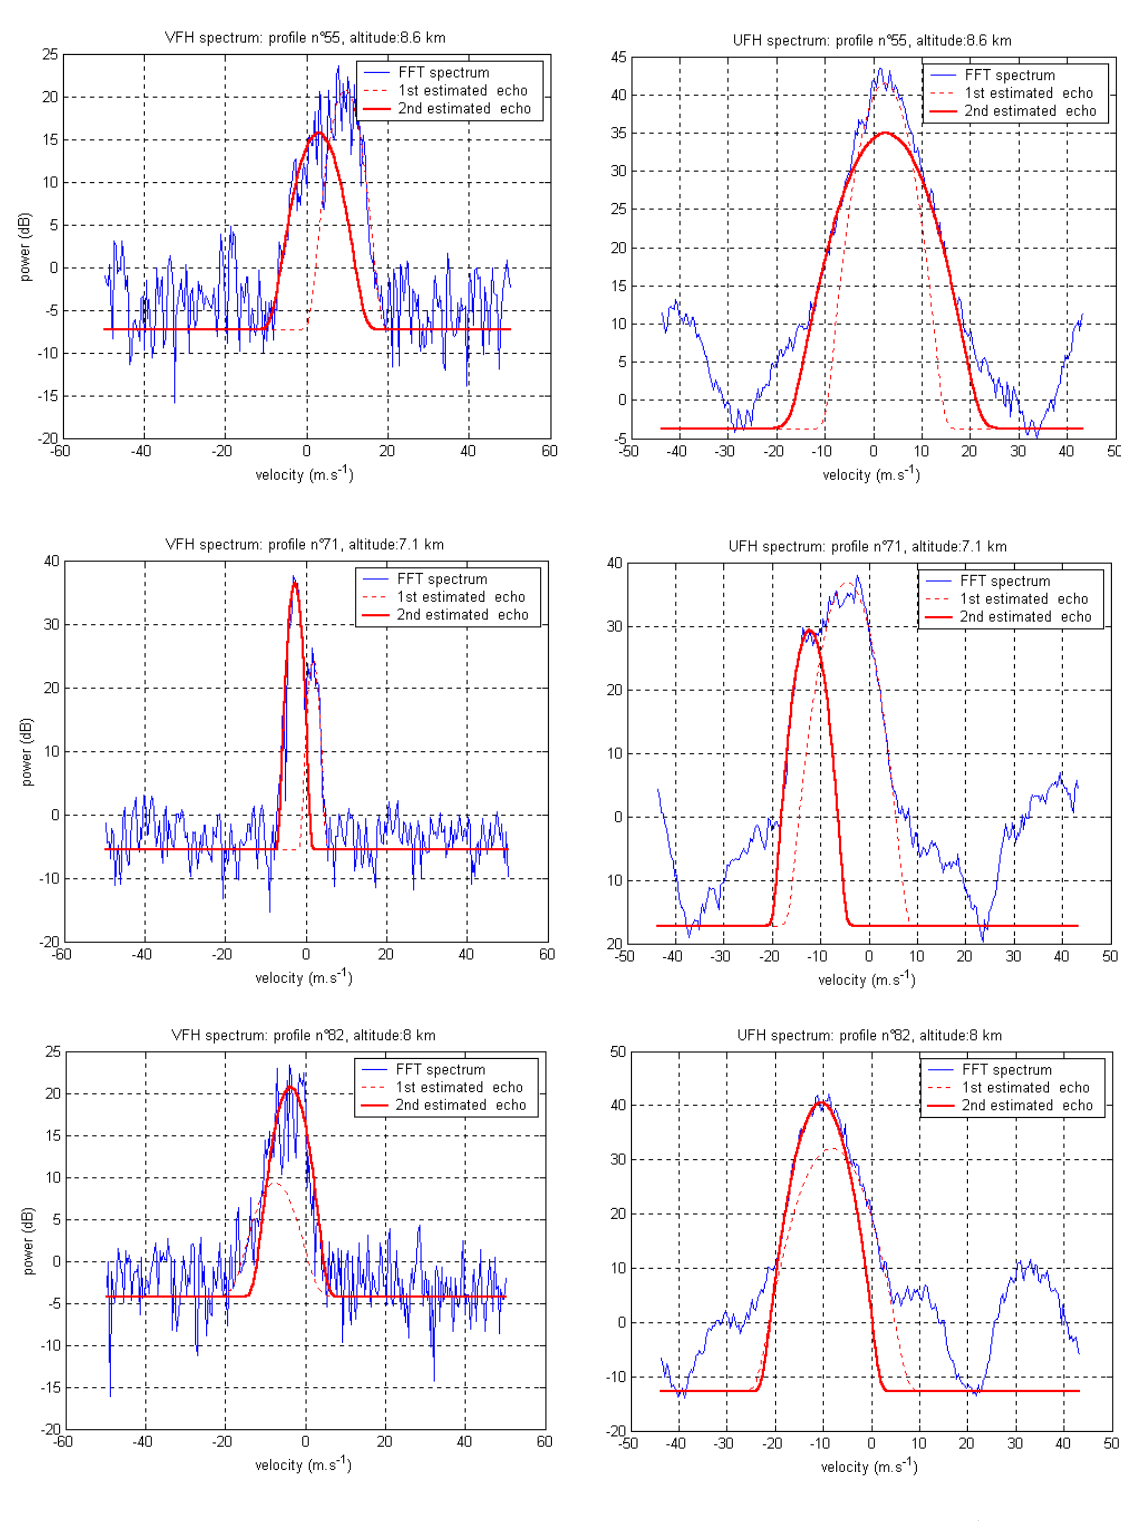
Figure 8 Fig. 8. SML estimation of air and hydrometeor echoes for a few profiles located in the strong downdraft area (the algorithm as not yet